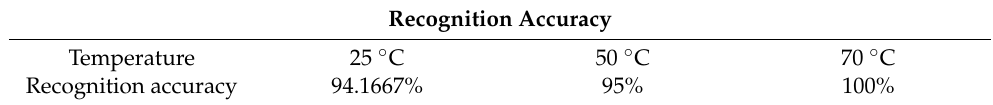
Table 7. Accuracy of multi-classification recognition of combined